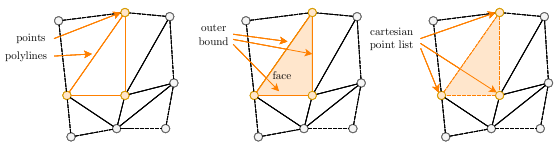
Figure 4. The same TIN may be represented with different representation concepts. left = IfcGeometricCurveSet, middle = IfcShellBasedSurfaceModel, right = IfcTriangulatedFaceSet